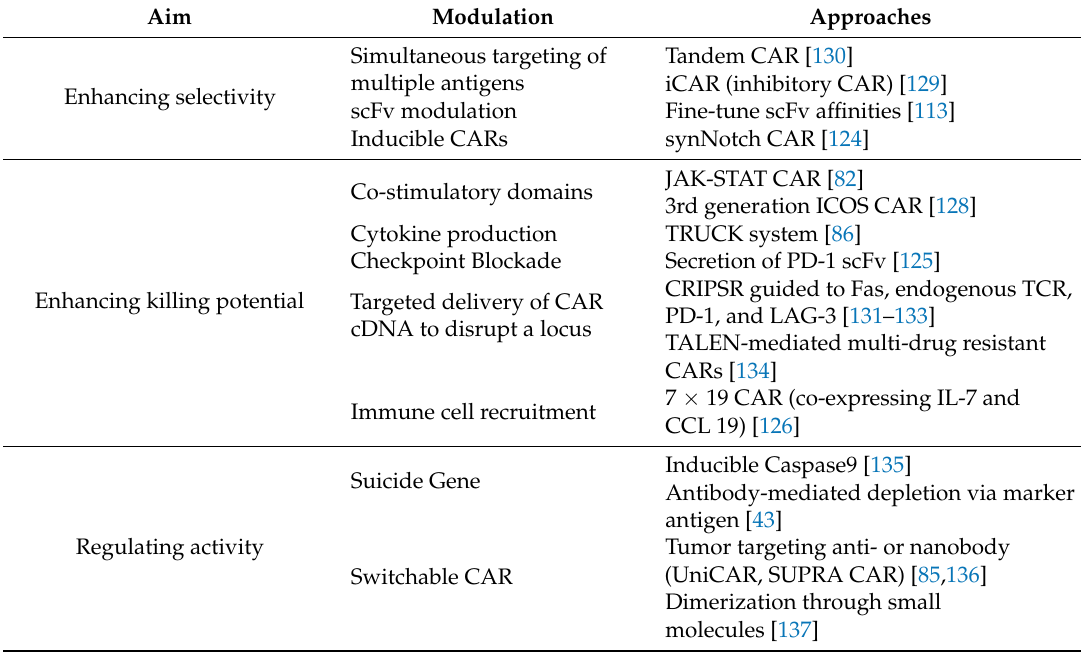
Table 1. Summary of the various approaches employed to regulate CAR T cell activity, and to enhance their selectivity and killing